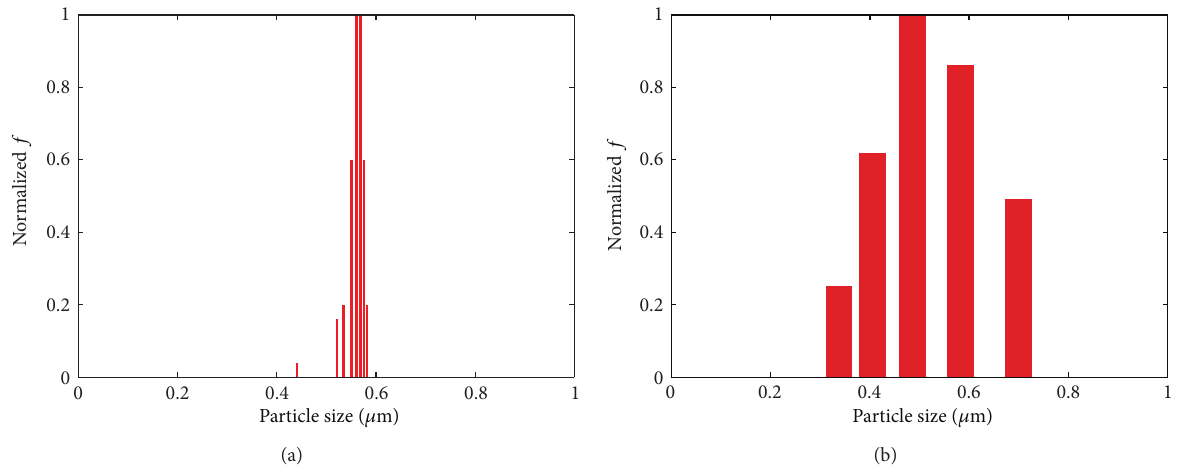
= 0.497 𝜇 m with (a) DCS ( 𝑥 nominal